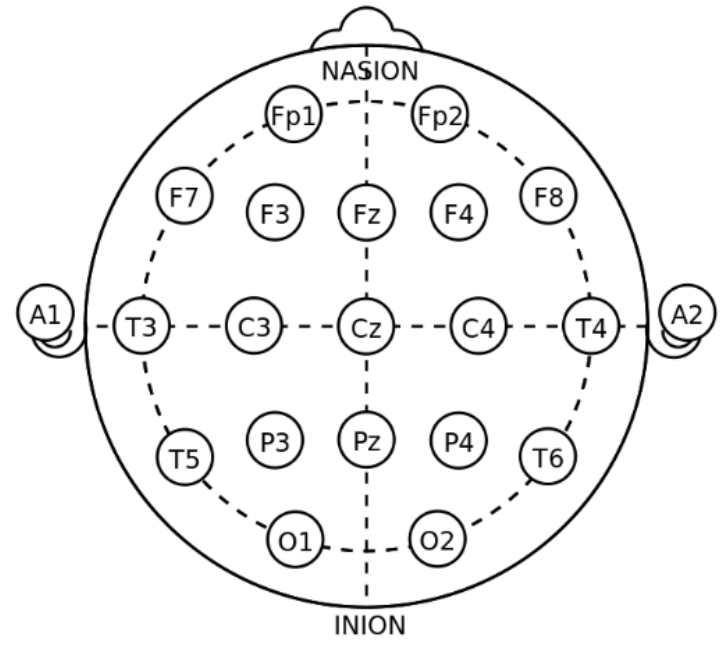
Figure 1. Position of 16 electrodes in international 10–20 system. Table 1. Properties of datasets with data.